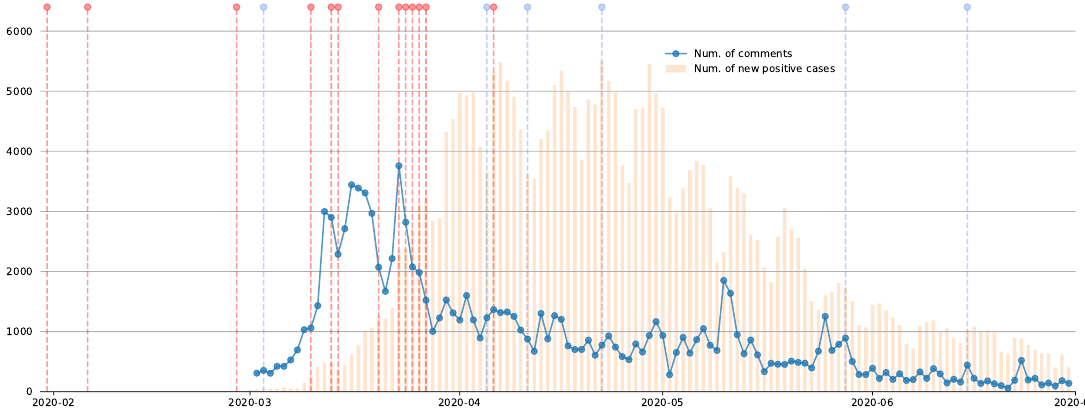
Figure 8. Number of comments per megathread in /r/sweden compared to the number of new daily cases in Sweden. Vertical lines represent adopted critical events and policies.